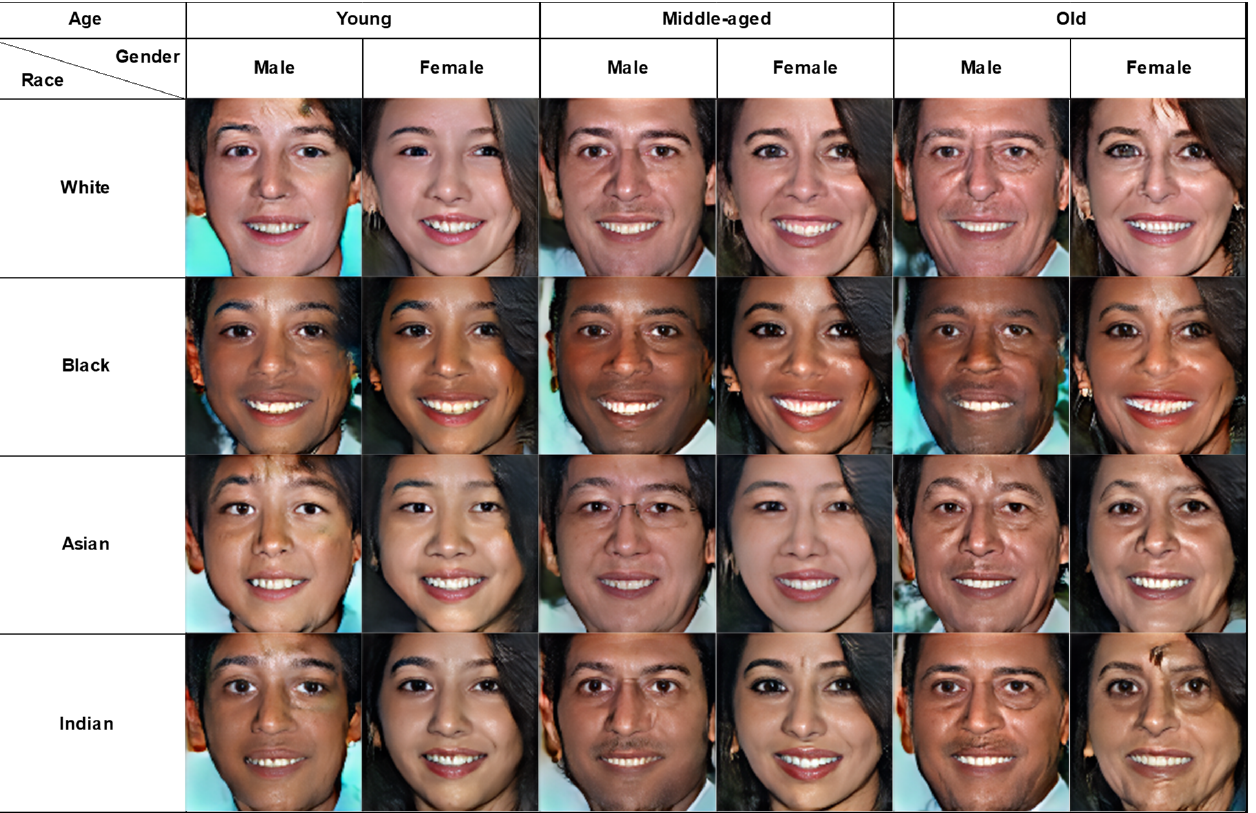
Figure 6. Third set of results of our model: faces from an identical latent vector with 24 different group